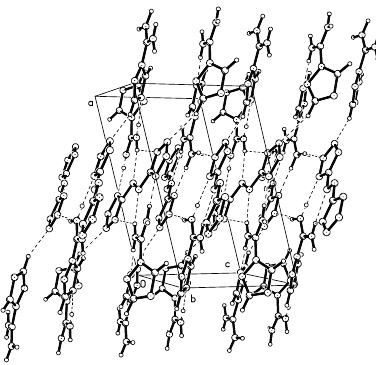
Figure 8. Packing diagram of 1 H -1,2,4-triazole-1-carboxamidine-5,5'-azotetrazolate ( 2 ). Dashed lines represent hydrogen